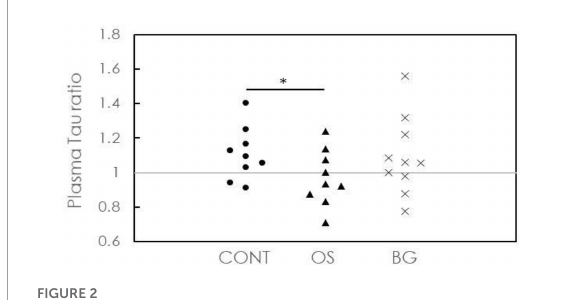
FIGURE3 Concentration ratios of plasma Aß1-42 after intervention to baseline for individuals in the control (CONT), olfactory stimulation with cognitive training (OS), and board game (BG) groups. Each symbol means each subject’s concentration ratio of the